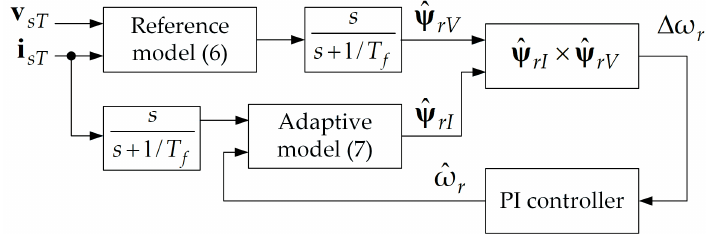
Figure 6. Block diagram of the MRAS-based speed estimation algorithm.